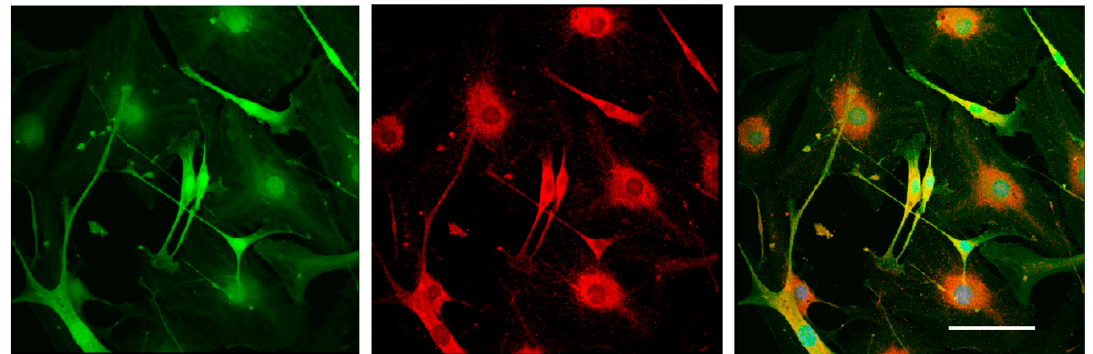
Figure 7. Immunofluorescent staining of glial cells derived from mouse DRGs after 3 days in vitro.